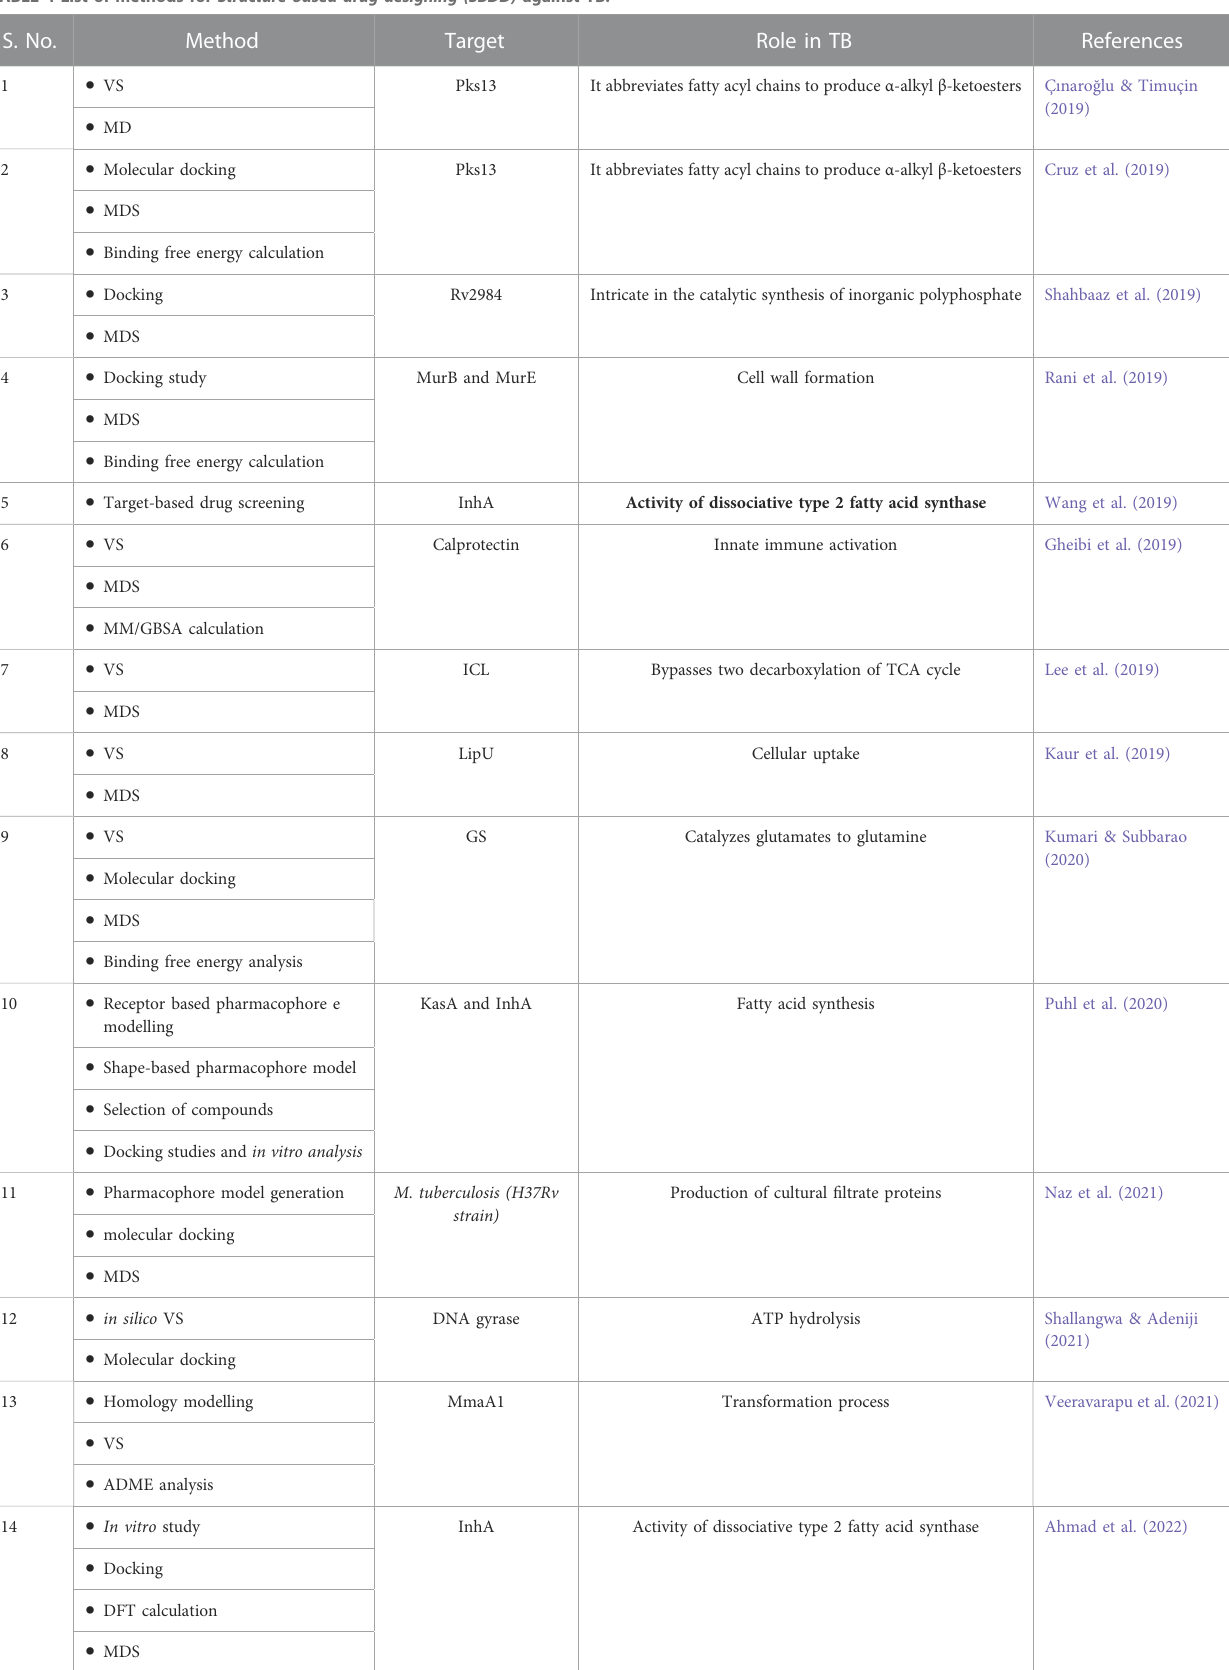
TABLE 4 List of methods for Structure based drug designing (SBDD) against TB. S.